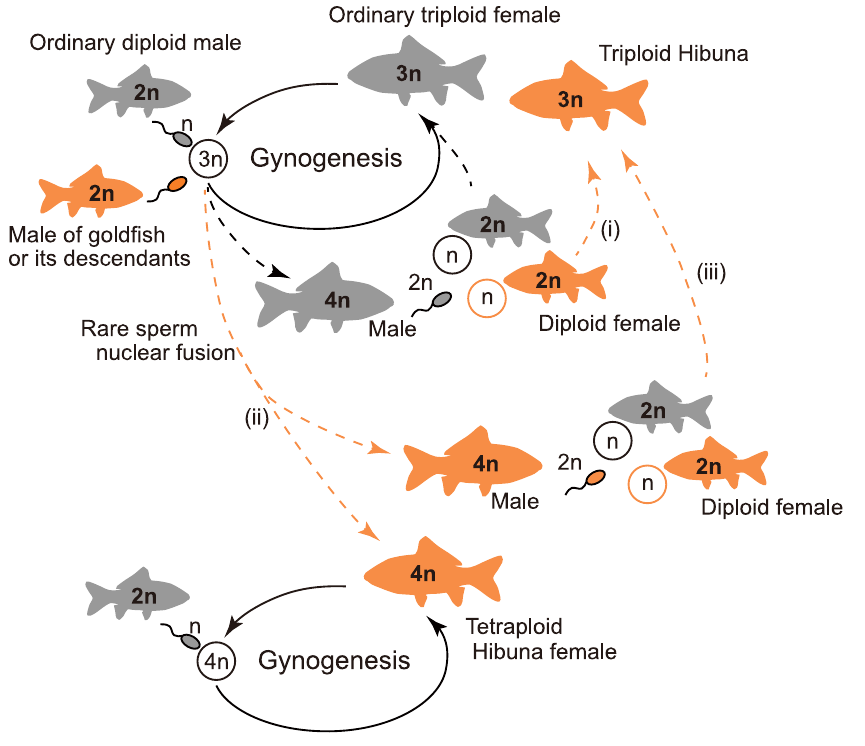
Fig 4. The expected scenario for the origin and diversification of Hibuna. Gray- and scarlet-colored fish symbols indicate ordinary and scarlet body color variants of Carassius fish, respectively. Scarlet dashed lines represent likelihood of introgression from goldfish to triploid